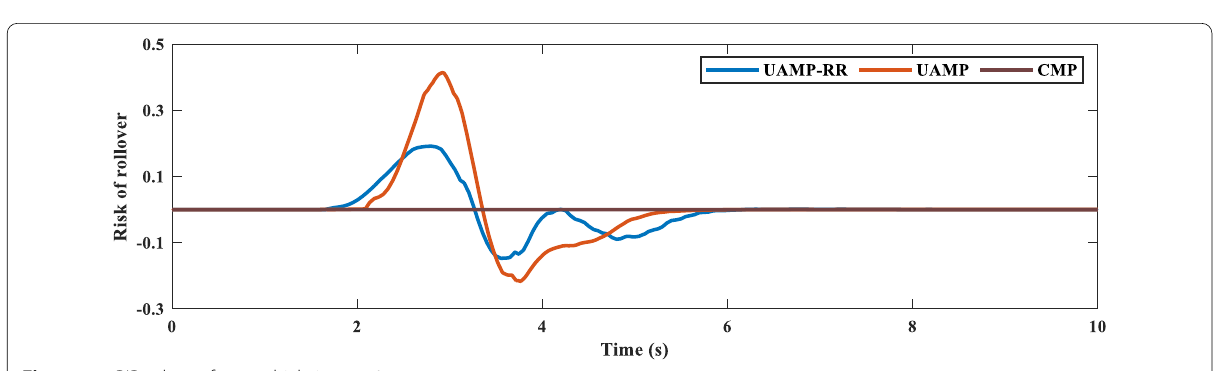
Figure 14 RIR values of ego vehicle in case